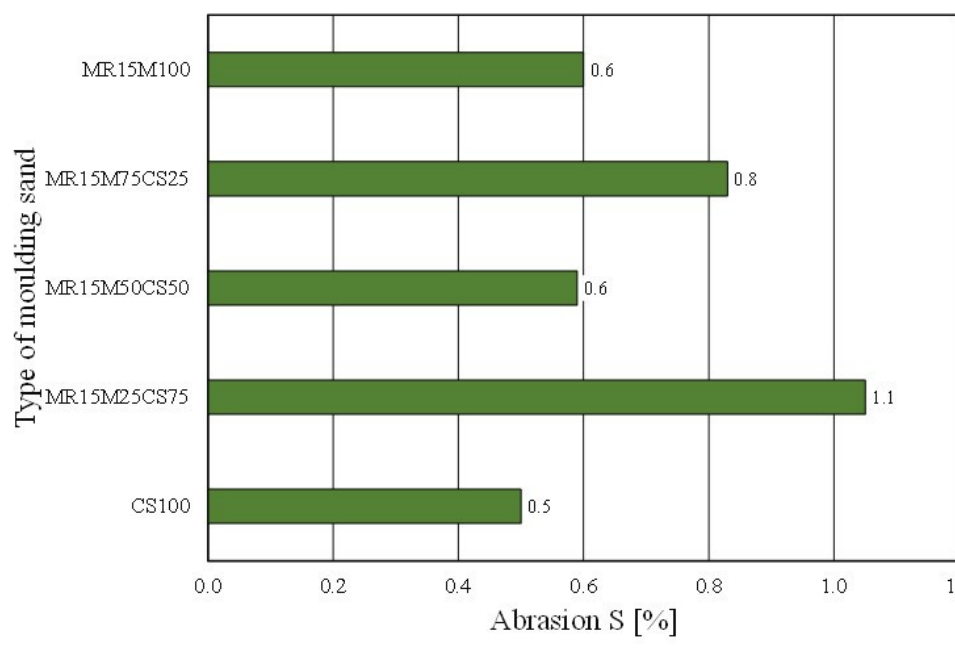
Figure 25. Abrasion S of tested moulding sands.